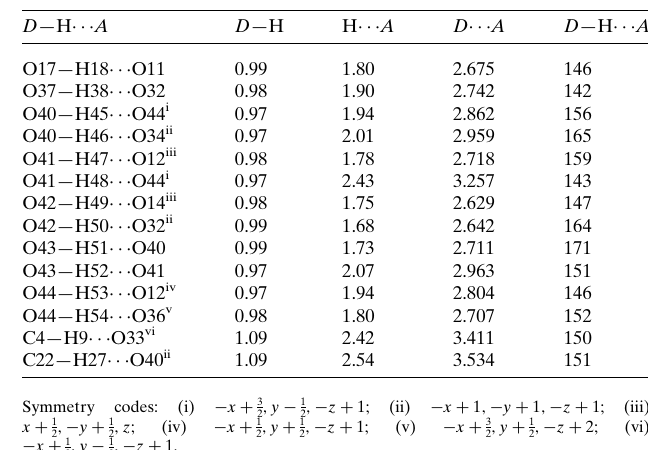
Table 1 Hydrogen-bond geometry (A˚ , (cid:3)